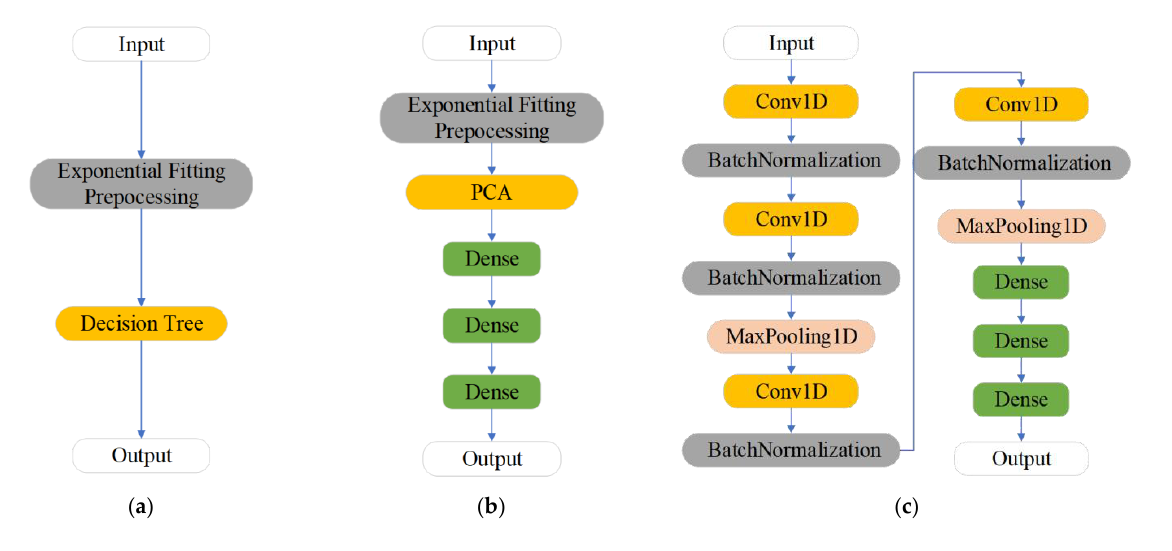
Figure 3. The models for classification and monitoring of the fruits: ( a ) the decision tree model composed of exponential fitting and decision trees; ( b ) the PCA model composed of exponential fitting, PCA, and dense layers; ( c ) the 1D-CNN model composed of one-dimensional convolutional layers, batch normalization layers, max-pooling layers, and dense layers.